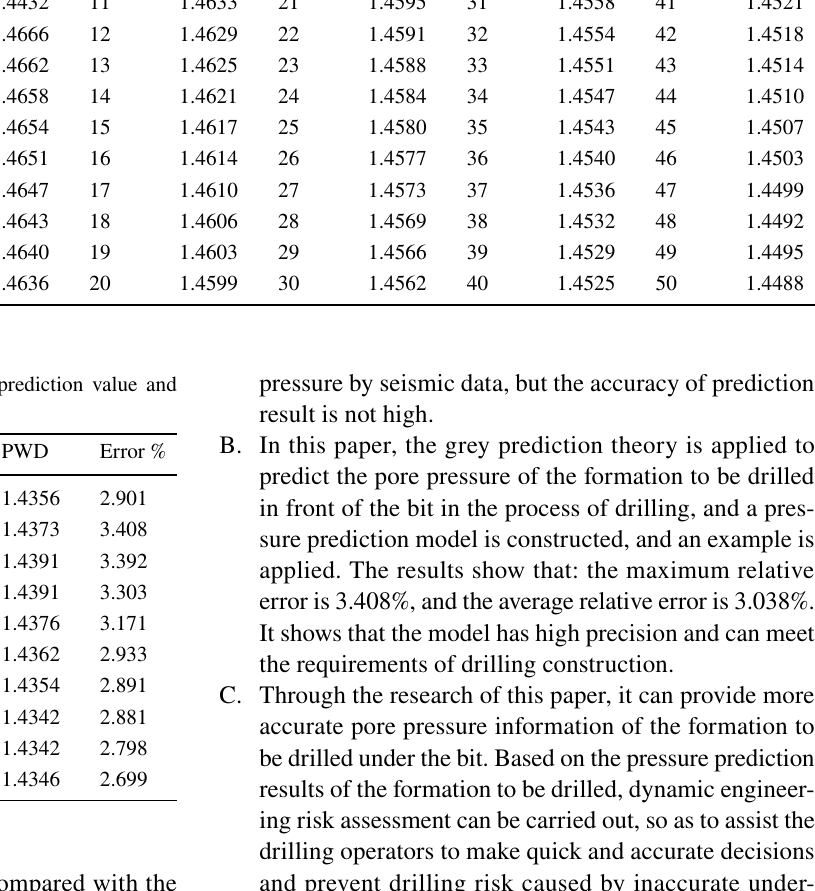
Table 5 Simulation value of pore pressure